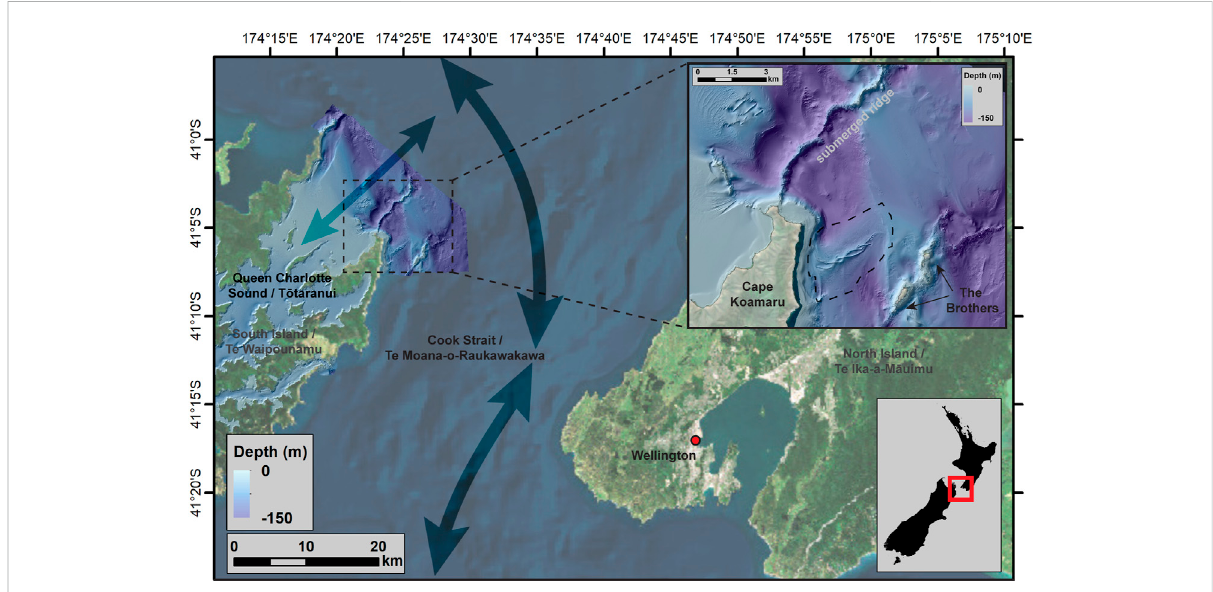
FIGURE 1 Regional bathymetric map of the western Cook Strait/Te Moana-o-Raukawakawa and outer Queen Charlotte Sound/T ō taranui (QCS) region (satellite imagery source: Esri). High resolution multibeam data collected during the HS51 survey is overlain within the QCS region. Arrows indicate thepredominanttidalcurrent directions along CookStraitandacross theentrance ofQCS. Black dashedbox delimitsthestudy area, shown indetail in the zoom-in inset. Zoom-in inset shows the bathymetric map of the study site, with the 2-m resolution HS51 bathymetry data collected in